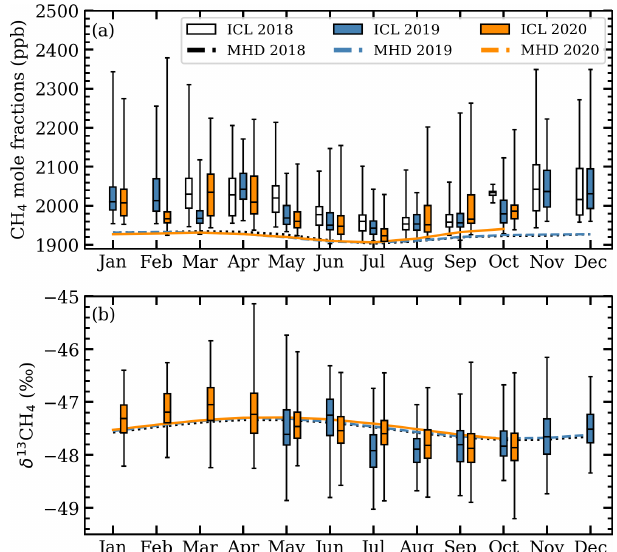
Figure 5. Seasonal cycles of detrended 20min measurements of (a) mole fractions and (b) δ 13 CH 4 at ICL (box plots) and Mace Head (lines) in which values deviate around 1 March 2018 ( t ref ) for mole fractions and around 1 May 2019 ( t ref ) for δ 13 CH 4 .